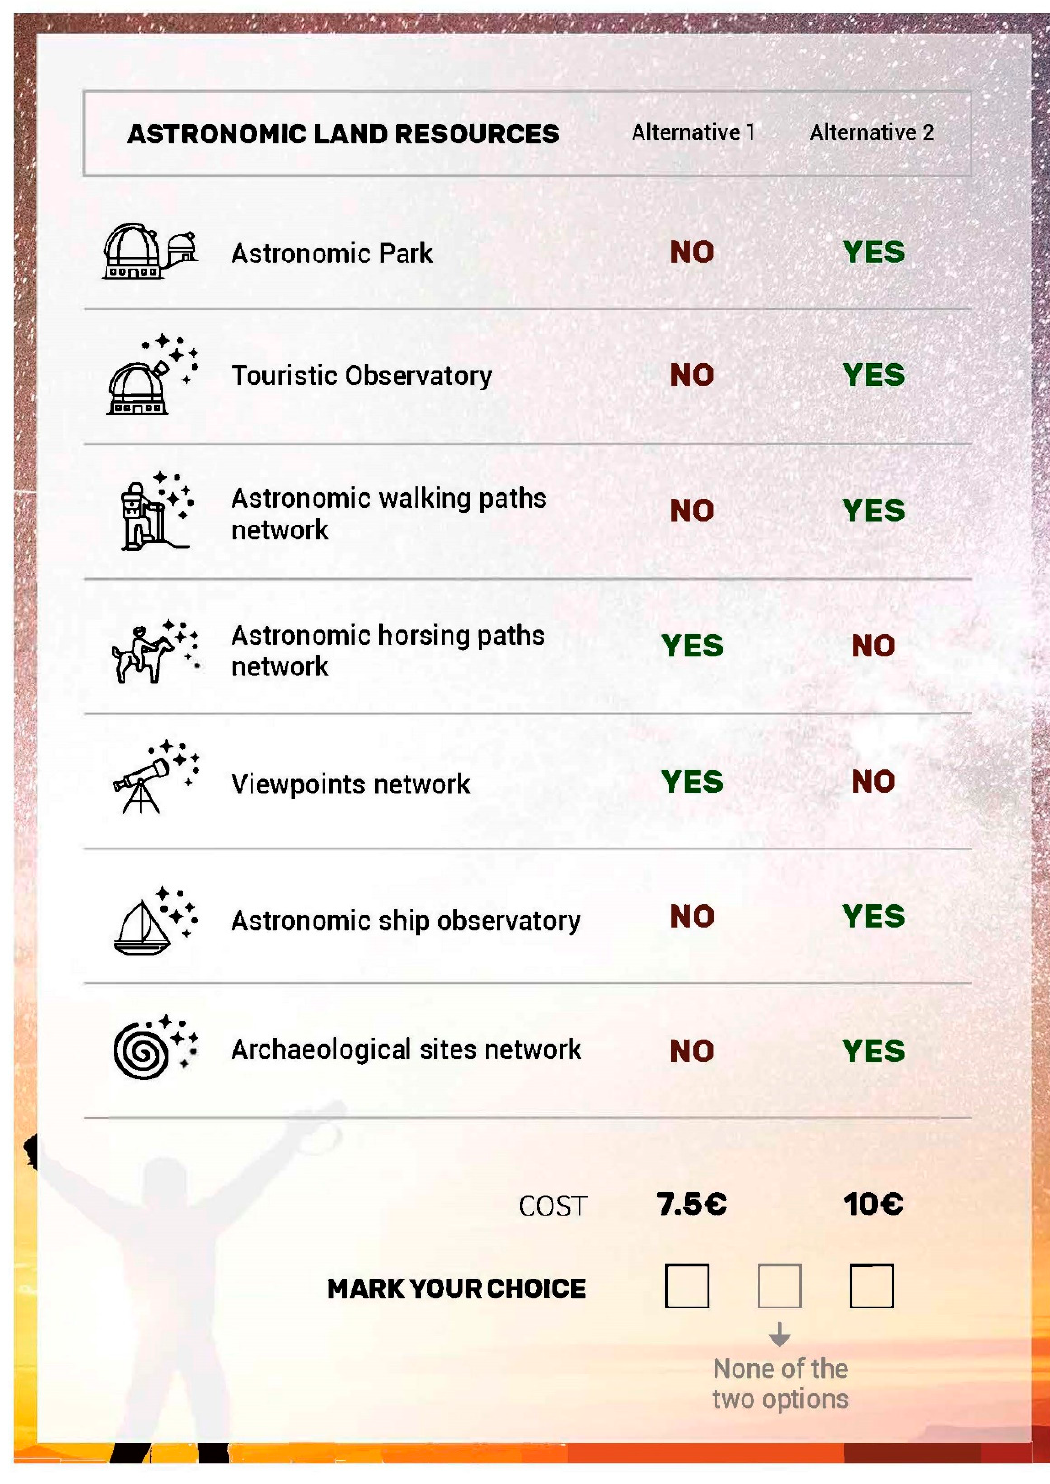
Figure 1. Example of a DCE choice card.